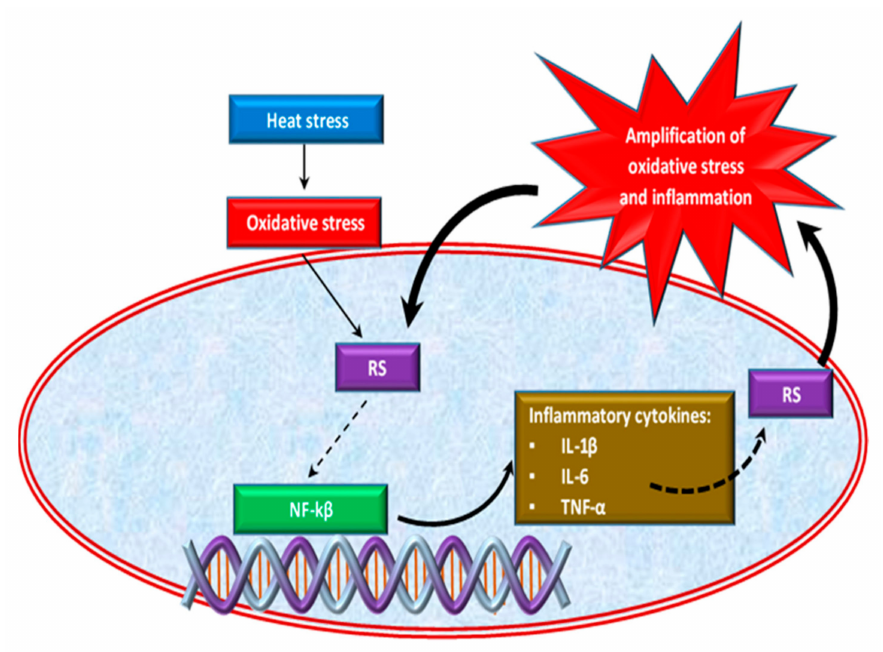
Figure 2. Effect of heat stress on inflammatory